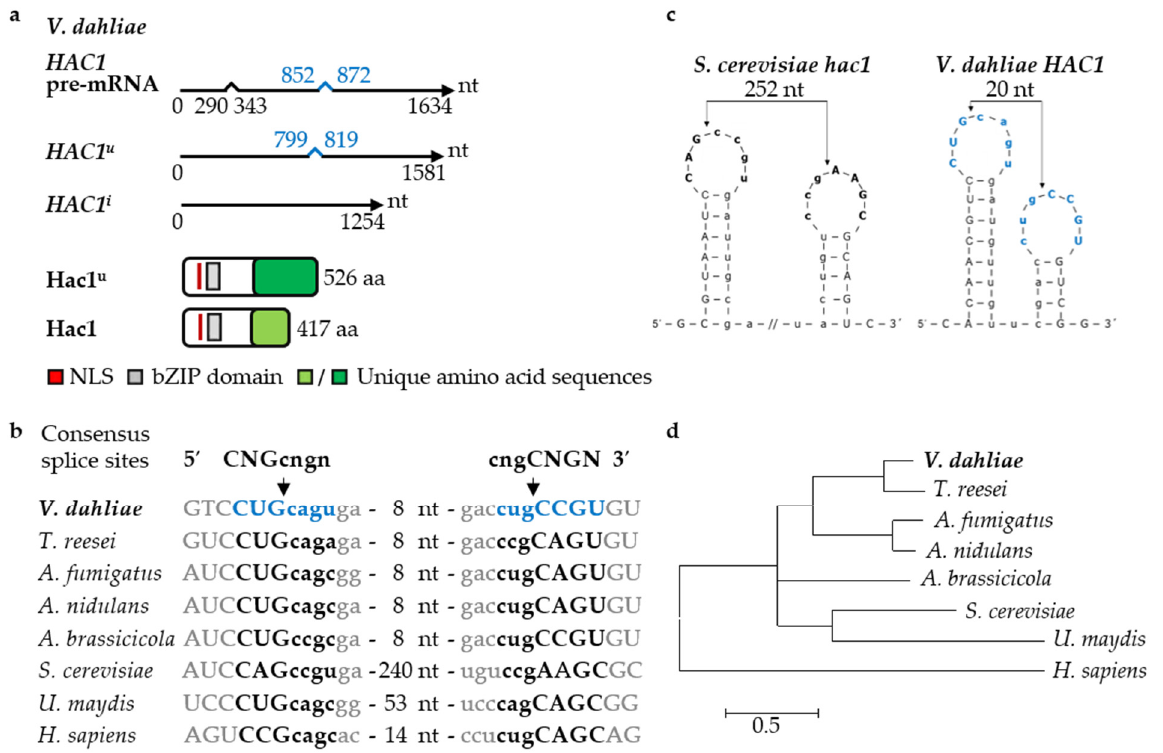
Figure 1. The Verticillium dahliae unfolded protein response regulator Hac1. ( a ) V. dahliae HAC1 mRNA and protein variants. The unspliced HAC1 pre-mRNA (1634 nt) contains a conventional (53 nt, black) and an unconventional (20 nt, blue) intron. Two HAC1 mRNA variants result from splicing of either the conventional intron, resulting in HAC1 u mRNA (1581 nt) encoding the potential 526 aa Hac1 u protein or additional splicing of an unconventional intron, resulting in the shorter induced HAC1 i mRNA (1254 nt) coding for the 417 aa Hac1 protein. Both proteins possess identical N-termini (268 aa) with basic leucine zipper domain (bZIP, grey, PS50217; 107–164 aa) and a nuclear localization signal (NLS, red, 94–105 aa), whereas Hac1 u and Hac1 C-termini are unique (dark vs. light green). ( b ) Unconventionally spliced introns of UPR regulators show high conservation. Sequences of 5 ′ - and 3 ′ -splice sequences of V. dahliae HAC1 , Trichoderma reesei hac1 (M419DRAFT_128619), Aspergillus fumigatus hacA (XM_743634), Aspergillus nidulans hacA (AN9397), Alternaria brassicicola HacA [31], Saccharomyces cerevisiae hac1 (NC_001138.5), Ustilago maydis cib1 (UMAG_11782), and Homo sapiens XBP1 (NM_005080.3) were aligned. (CNG’CNGN = consensus sequence [86], arrows = cleavage sites, lowercase characters = intron sequences, capital letters = splice sequences, numbers of nucleotides are given for those not shown). ( c ) Predicted twin stem-loop secondary structures of 5 ′ - and 3 ′ -splice sequences of unconventional V. dahliae and S. cerevisiae HAC1 introns. (Arrows = cleavage sites, bold characters = splice sequences, lowercase characters = introns, // = discontinuation of intron sequence) ( d ) Phylogenetic tree derived of Hac1-like proteins. V. dahliae Hac1 (Figure S6), T. reesei HACI i (XP_006964054.1), A. fumigatus HacA i (ACJ61678.1), A. nidulans HacA i (Q8TFU8.2), A. brassicicola AbHacA [31], S. cerevisiae HAC1 i (NP_116622.1), U. maydis cib1 s (XP_011390112.1) and H. sapiens XBP1 (NP_001073007.1) sequences were used (Muscle algorithm, scale bar = average number of amino acid substitutions per site).